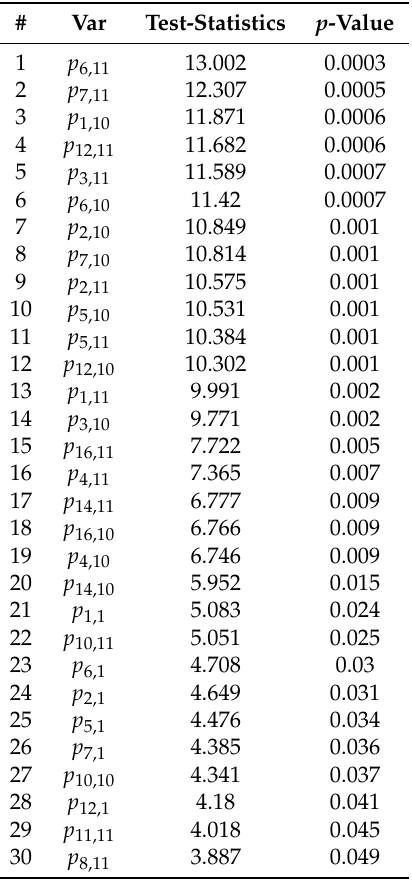
Table 4. χ 2 test